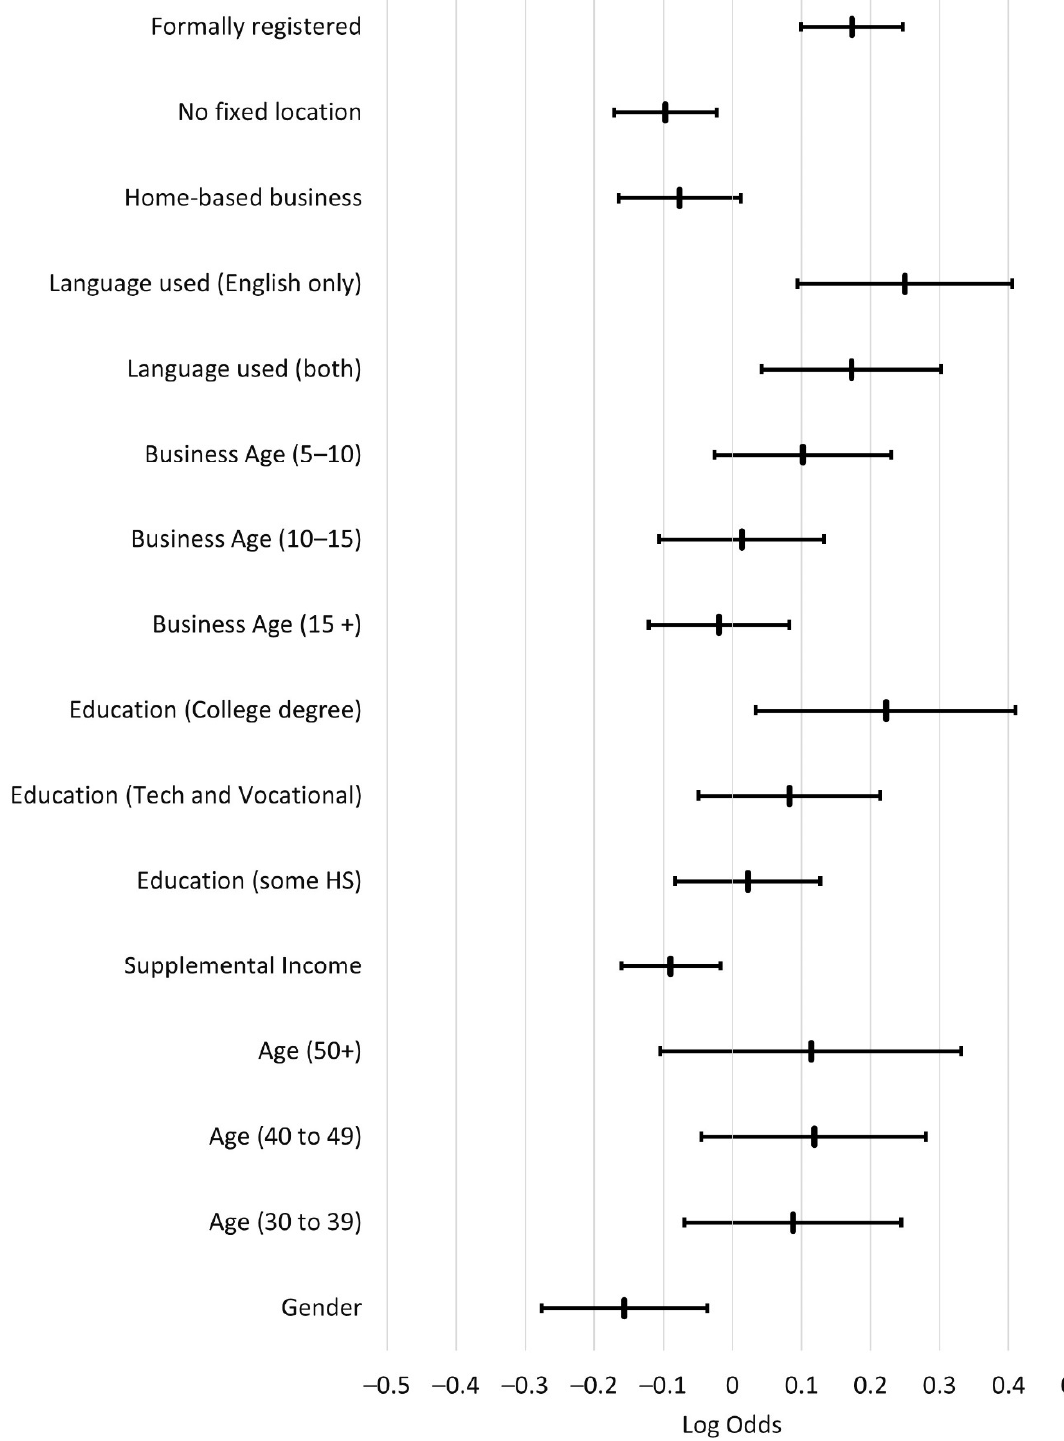
Figure 2. Coefficient estimates and 95% confidence intervals for the high sales category.